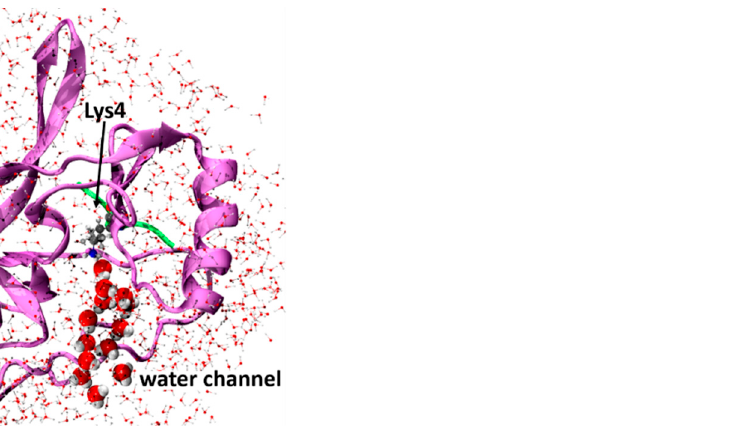
Figure 1. Graphical representation of the water channel connecting Lys- ε -NH 3+ with the outside of the MLL3 enzyme. (purple ― MLL3 subunit; green ― peptide substrate; gray ― carbon; red ― oxygen; blue ― nitrogen; white ― hydrogen).